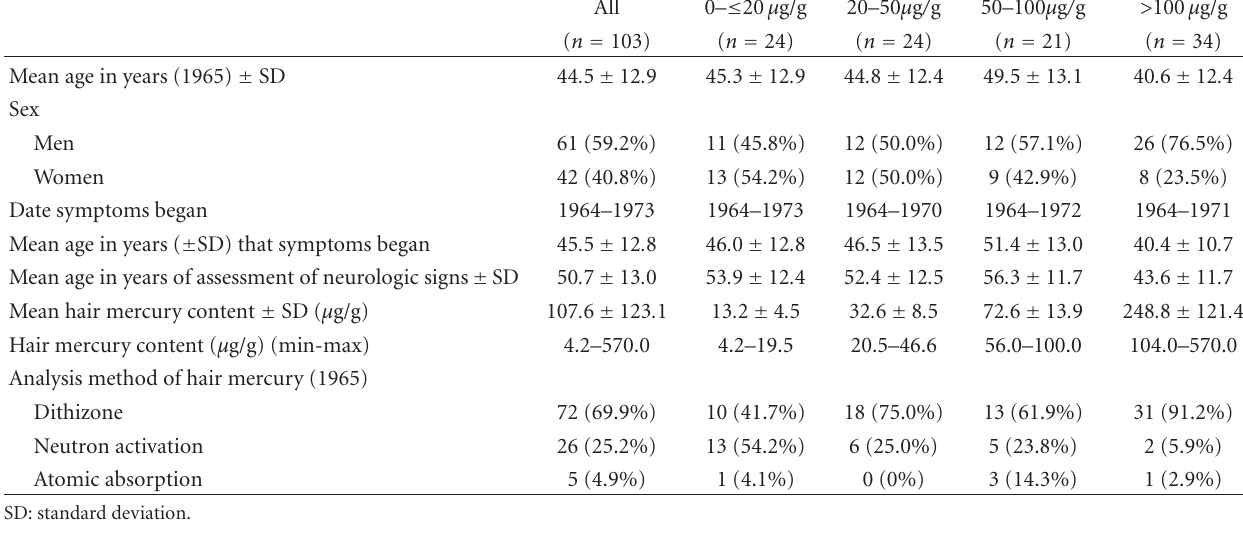
Table 2: Characteristics of subjects by hair mercury content.